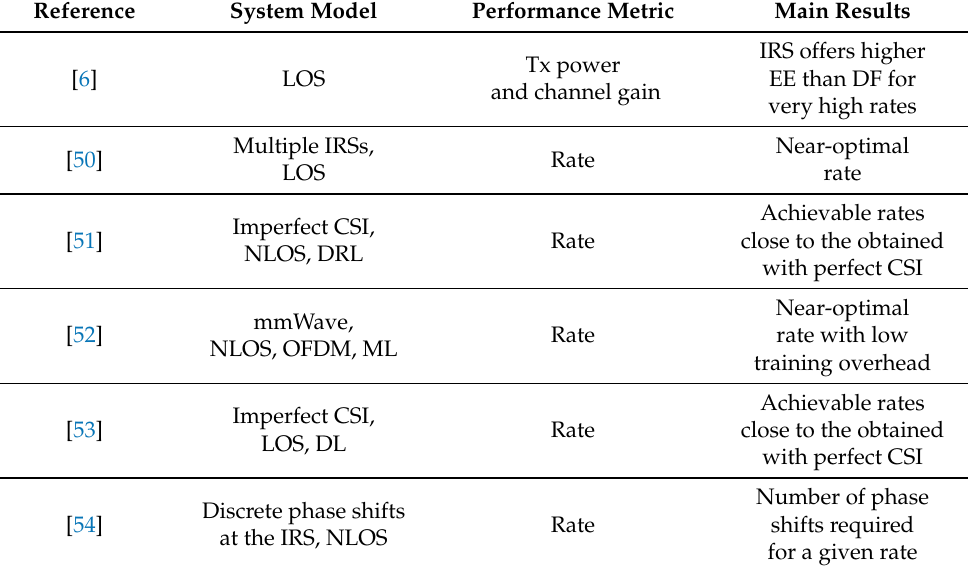
Table 1. Single-user SISO approaches.